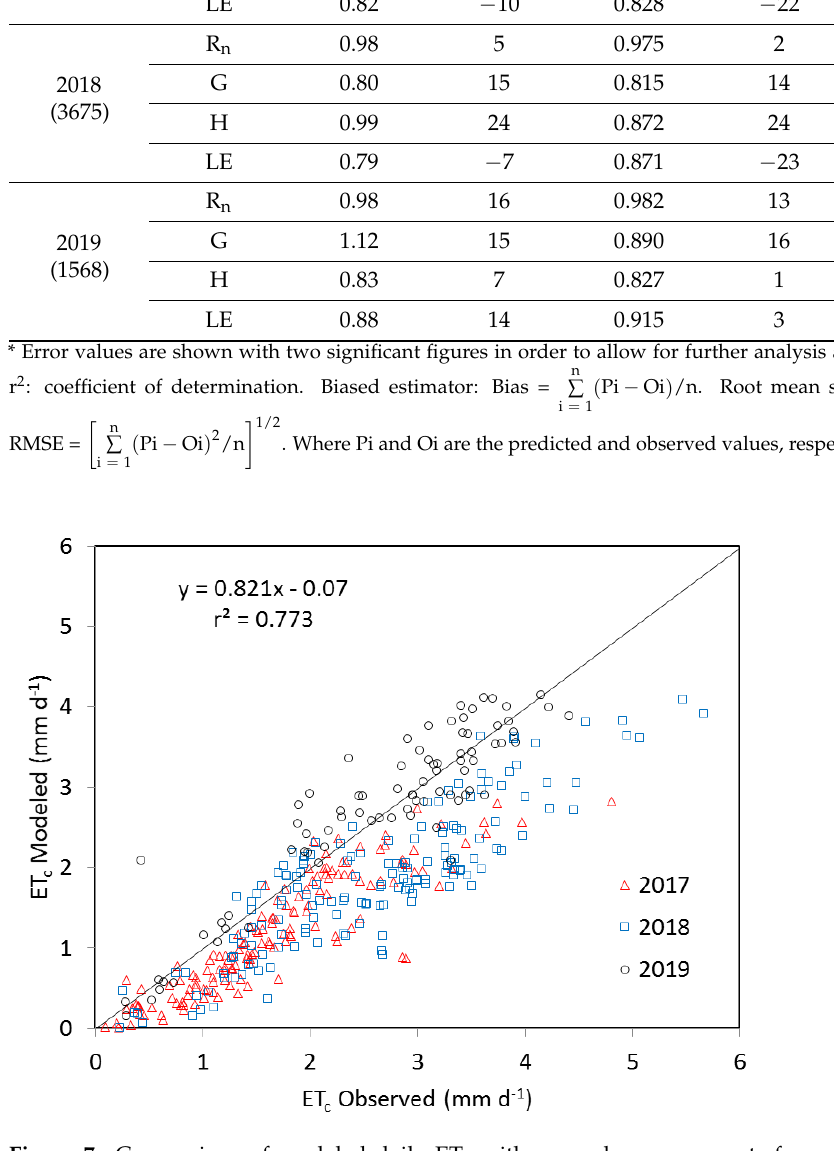
Figure 7. Comparison of modeled daily ET c with ground measurements from corrected eddy-covariance measured values, for the 2017–2019 experimental campaigns. Residual technique was applied to force the EB closure.